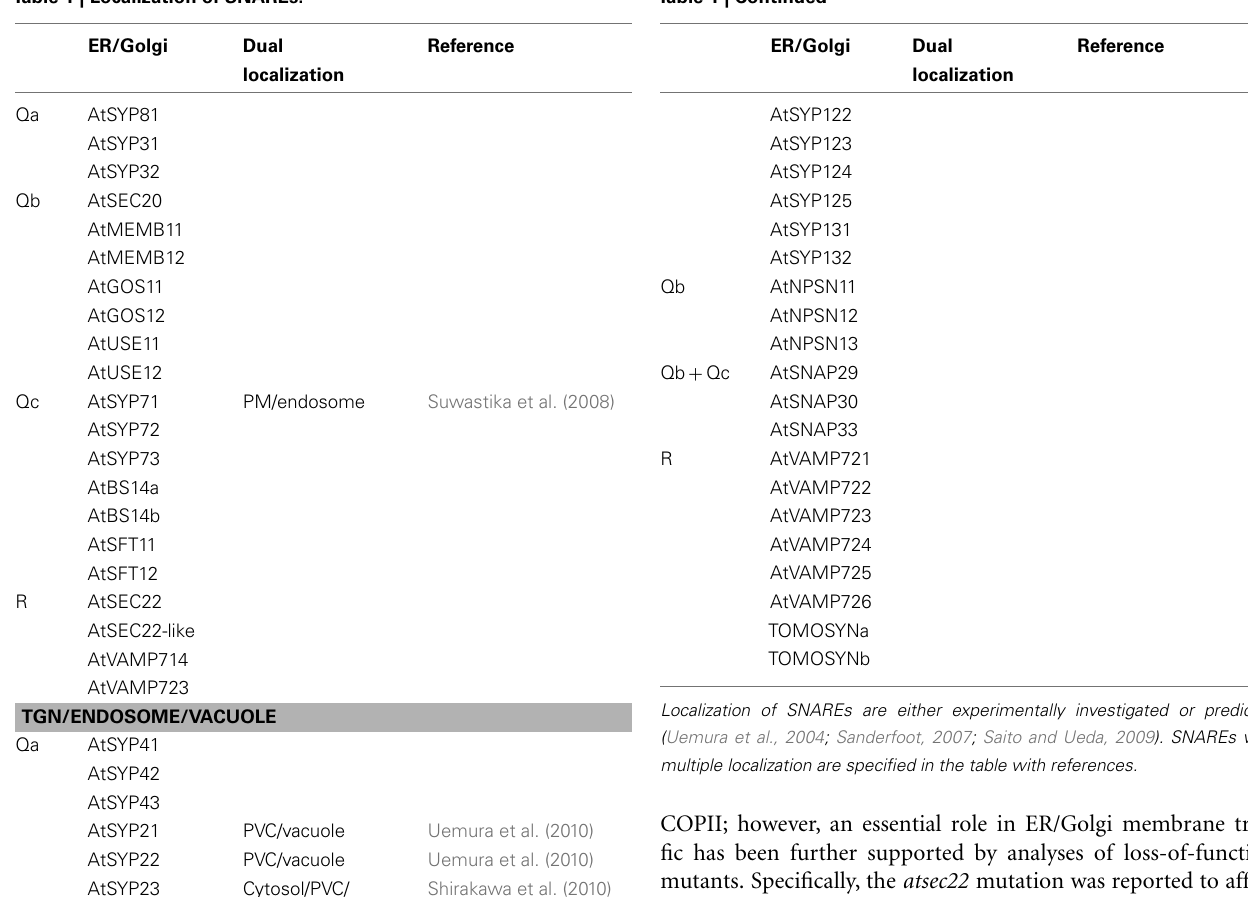
Table 1 | Localization of